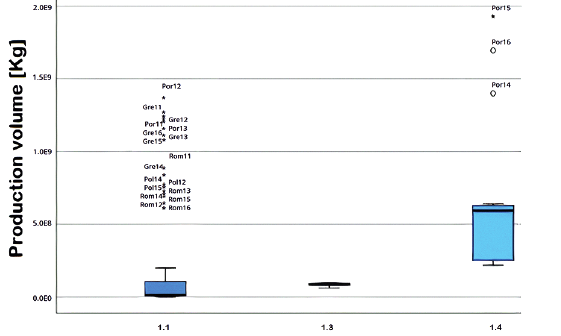
Figure 12. Post-crisis box diagram of production variable according to the clusters of the second two-stage clustering level (source: own elaboration)